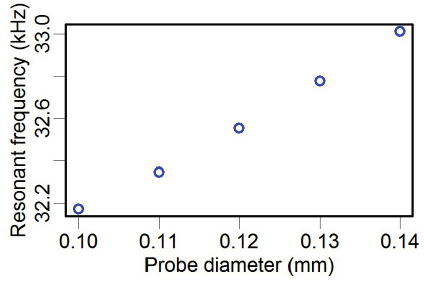
Figure 18. Resonance frequency with varying probe